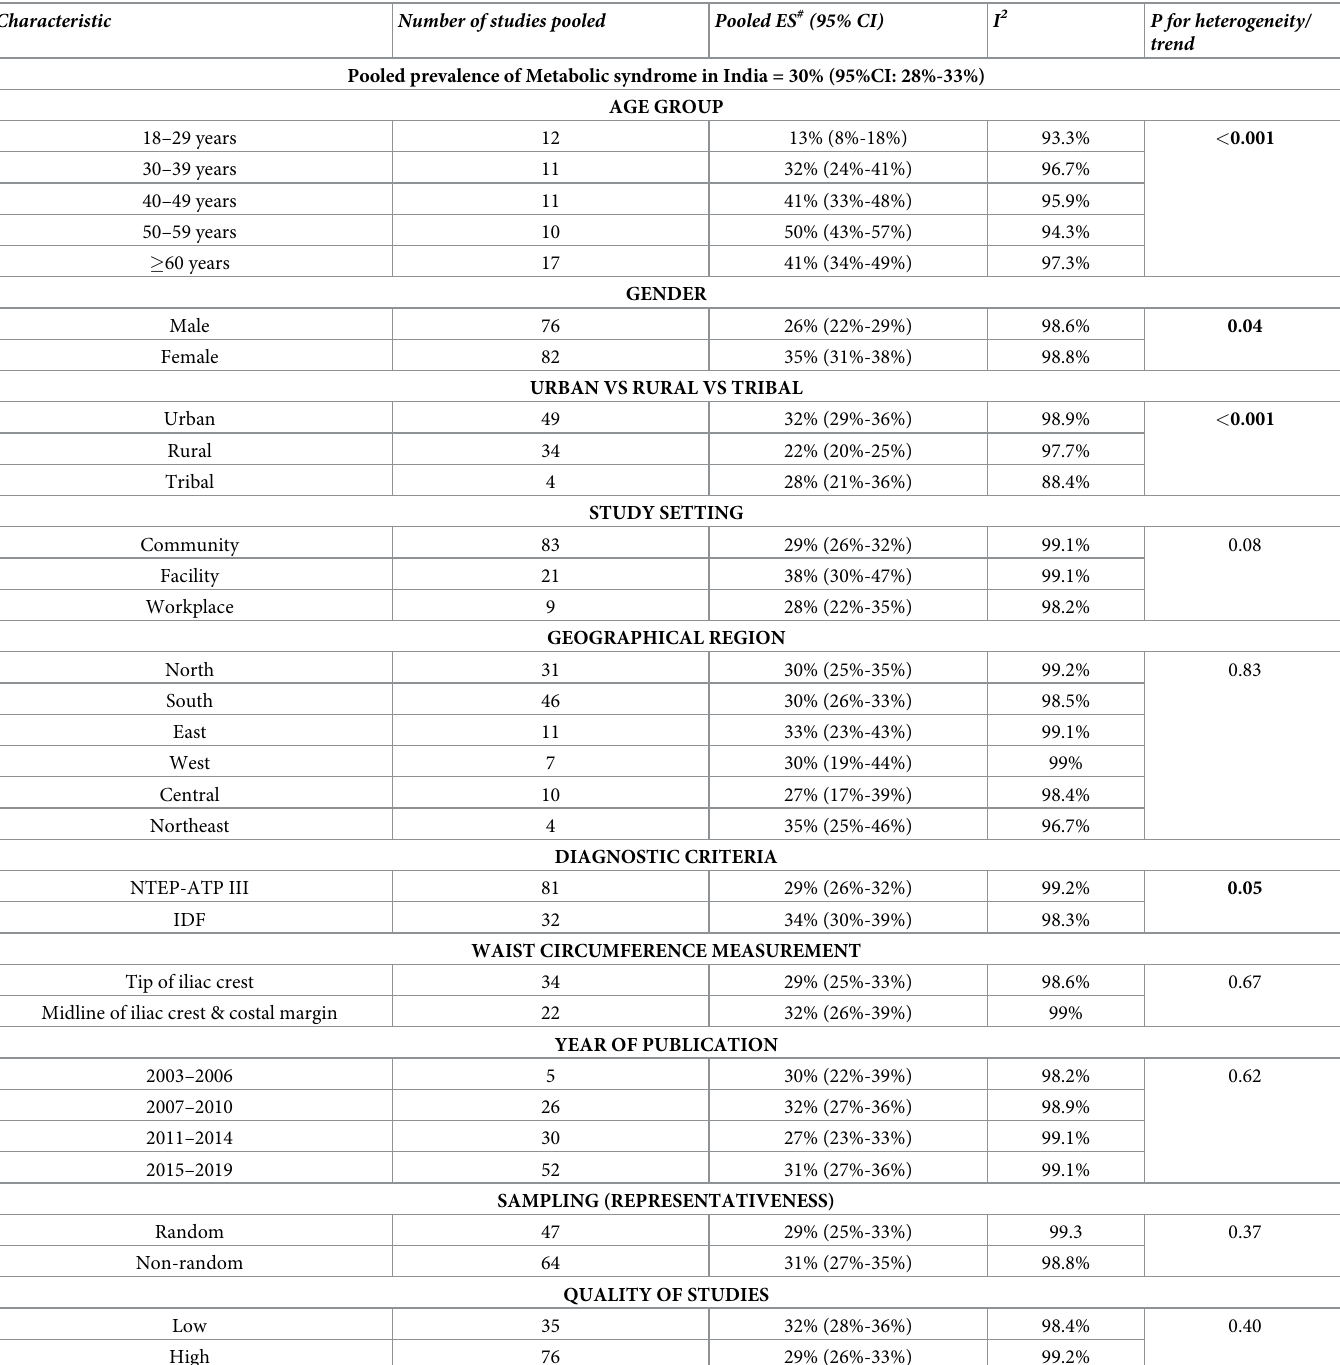
Table 2. Summary of findings and subgroup analysis of studies reporting prevalence of metabolic syndrome in India.